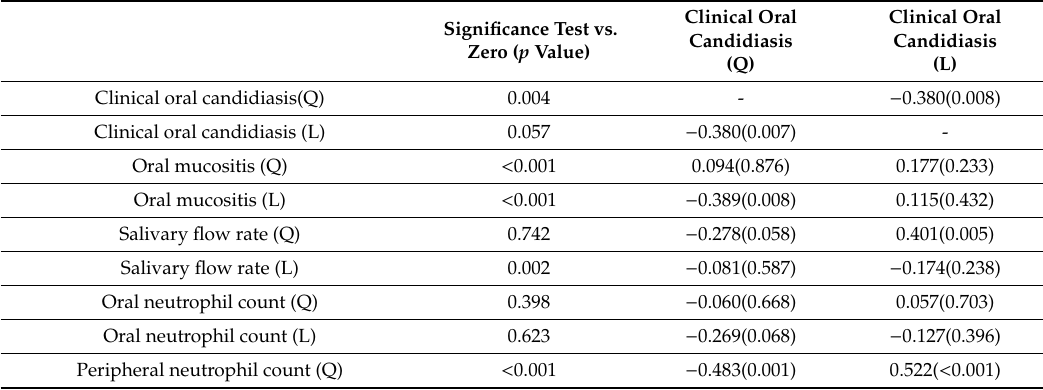
Figure 2. Incidence of oral candidiasis during one chemotherapy cycle and associated changes in salivary flow and neutrophil surveillance. ( A ) Oral candidiasis incidence. ( B – D ) Changes in salivary flow rate, peripheral neutrophil counts, and oral neutrophil counts between baseline and the first visit with candidiasis. ( E , F ) Changes between baseline and V4 in the ability of peripheral neutrophils to kill C. albicans in all cancer subjects and in subjects that tested positive for oral candidiasis, during the cycle. * indicates a p value < 0.05, when comparing subject-matched data via Wilcoxon Rank tests. Table 3. Correlation between change in oral candidiasis signs during the cycle and the change in clinical and microbiome characteristics measured longitudinally. All 45 subjects were included in these analyses.